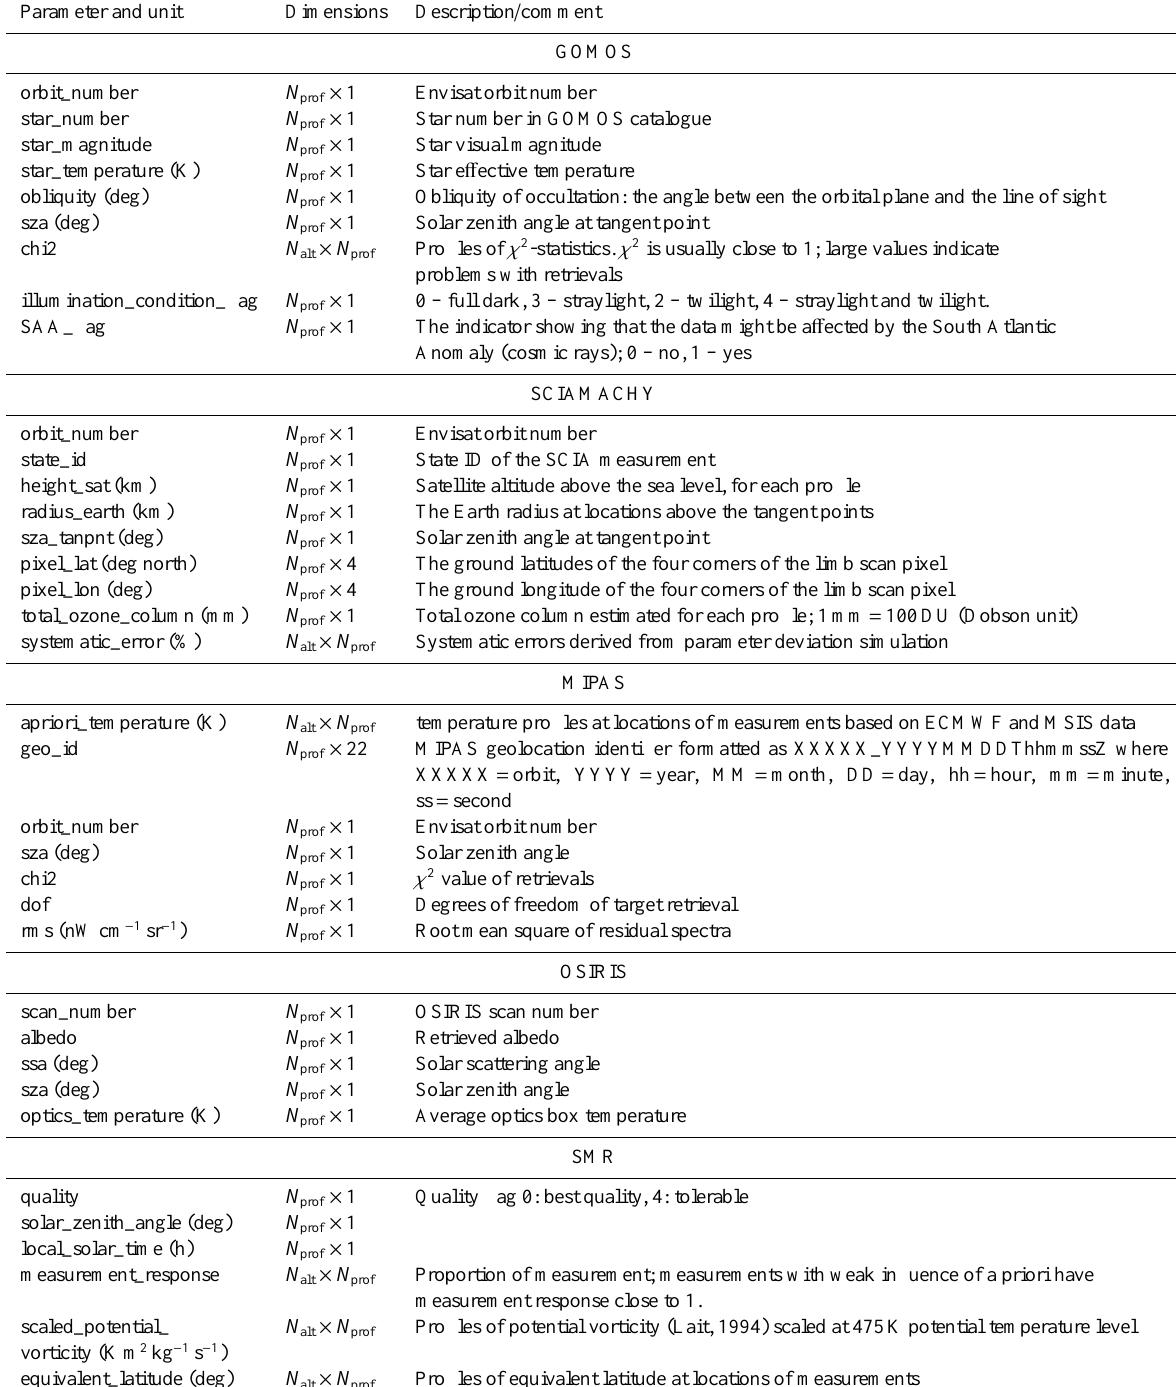
Table 3. Optional parameters in the HARMOZ netCDF files. N alt and N prof denote the number of pressure levels and the number of profiles,